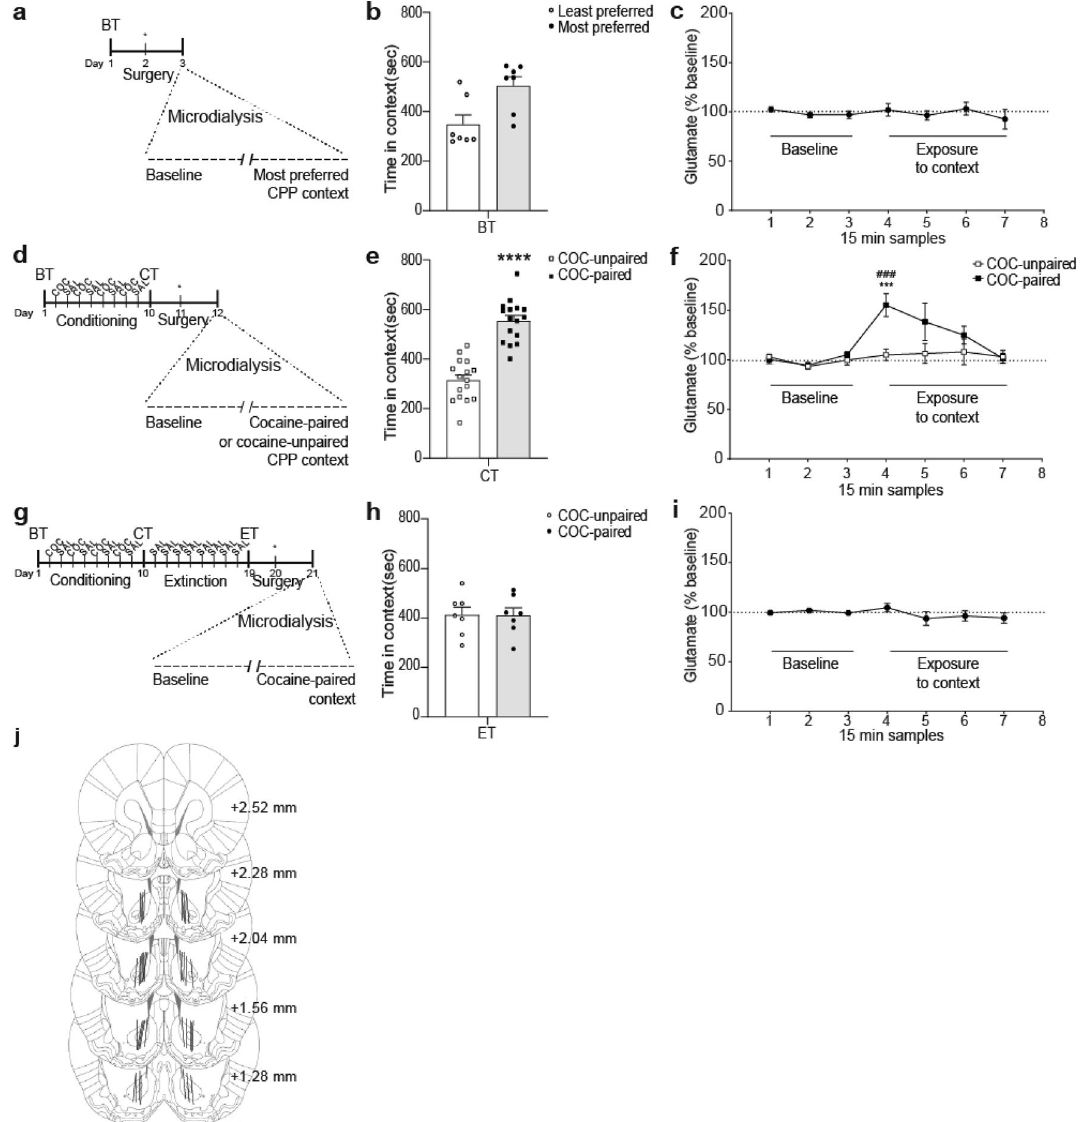
Figure 5. Enhancement of extracellular glutamate in NAcore depended on the CPP context and on the phase of the reinstatement of cocaine-CPP procedure. ( a , d , g ) Timelines of CPP procedures. The day after surgery for probe implantation, in vivo microdialysis was performed to sample (every 15 min) extracellular glutamate in NAcore both before (baseline, in home cage) and after transfer of animals to either compartment of the CPP apparatus. ( b , e , h ) Time spent (seconds) in each CPP context during the previous corresponding test, using CPP LIADE software, version 1.2 (http:// www. liade. inv. efn. uncor. edu/). Bars in dot plots represent mean ± s.e.m. The two-tailed paired Student’s t test was used to analyze these data. ( c , f , i ) For microdialysis, values represent percentage of increase in glutamate release from baseline (mean ± s.e.m.) for each sample using Bonferroni’s multiple comparisons post-hoc test was used. Glutamate was quantified using EZChrom Elite software, version 4.0 (http:// www. agile nt. com). Naïve animals (n = 7) that showed a statistically non-significant trend to unconditioned preference for either CPP compartment during BT ( b ) did not exhibit any change in extracellular glutamate when they were transferred to the most-preferred context ( c ). In contrast, after the conditioning phase, animals that expressed a significant conditioned preference for the cocaine-paired context during CT ( e , ****p < 0.001, n = 16 ) then demonstrated a context-specific augmentation of extracellular glutamate ( f , ***p < 0.001 compared with the cocaine-unpaired context group at the same time point; ### p < 0.001 compared with the last baseline sample, n = 8 for each group). After confirming extinction of the cocaine-CPP behavior ( h ), animals did not exhibit any significant change in extracellular glutamate when they were re-exposed to the previous cocaine-paired context ( i , n = 7). ( j ) Summary illustration of the locations of the active membrane (solid lines) of the microdialysis probes in the NAcore of subjects that were included in the analysis of the data presented in this figure. Numbers to the right indicate millimeters from the